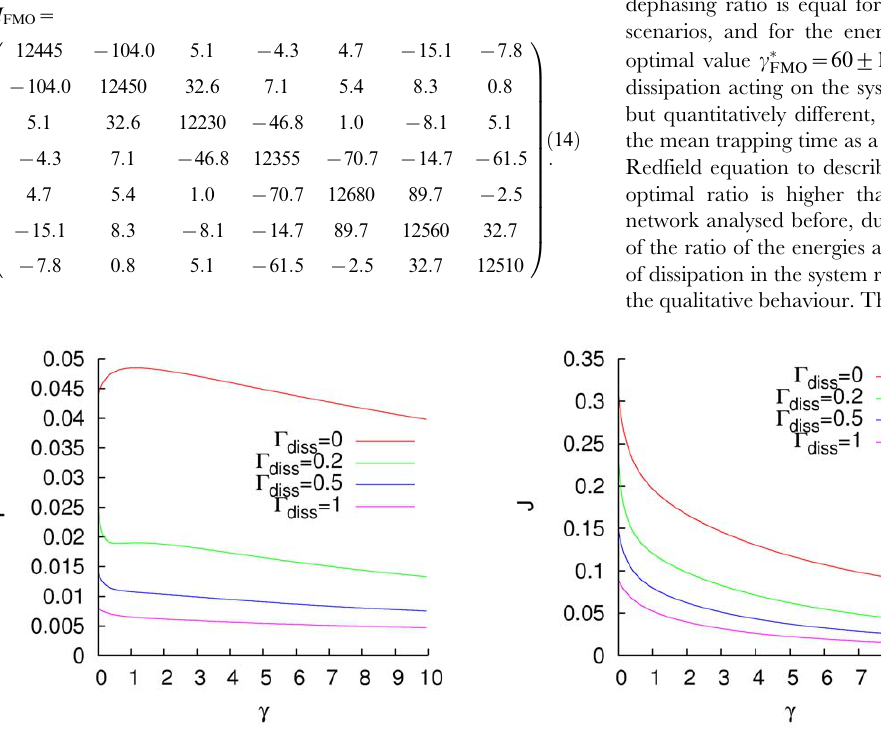
Figure 2. Excitation (left) and energy (right) fluxes for a homogeneous fully connected network, B v i ~ B g ij ~ 1cm { 1 V i , j , with a thermal mean excitation number n ~ 100 , and different dissipation rates C diss . Units of cm { 1 .